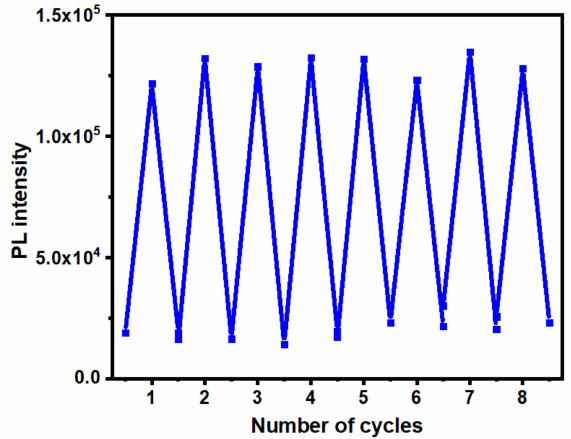
Figure 6. Recyclability study of M1 with DCM vapors. The emission of M1 after being exposed to DCM vapor returns to its original intensity by heating it at 80 ◦ C continuously for 30 s.